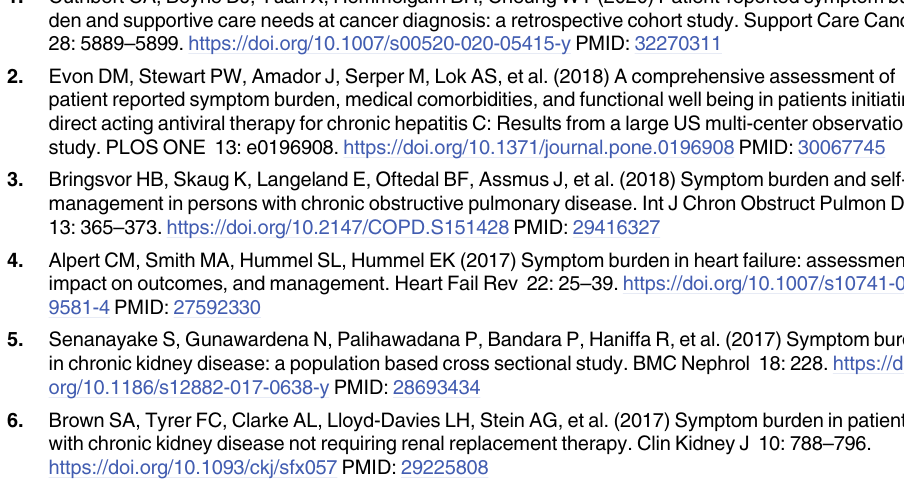
S5 Table. Baseline characteristics of people with more than one survey. S6 Table. Principal component loadings of all symptoms prior to final cluster composi- tion. S7 Table. Summary of changes total symptom cluster scores and changes in usual activities score and per treatment